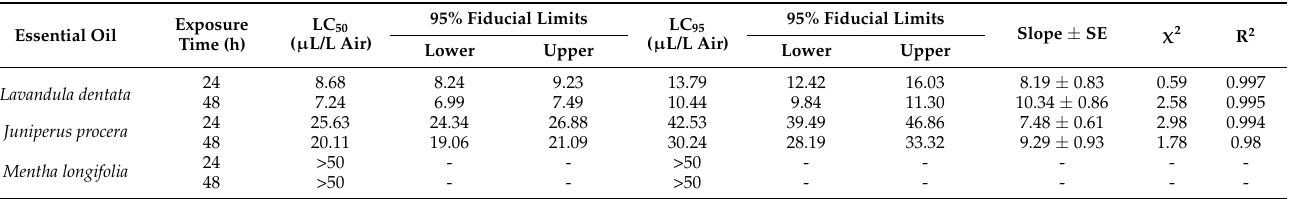
Table 4. Fumigant toxicity indices of Lavandula dentata , Juniperus procera , and Mentha longifolia essential oils against the land snail Monacha obstructa .